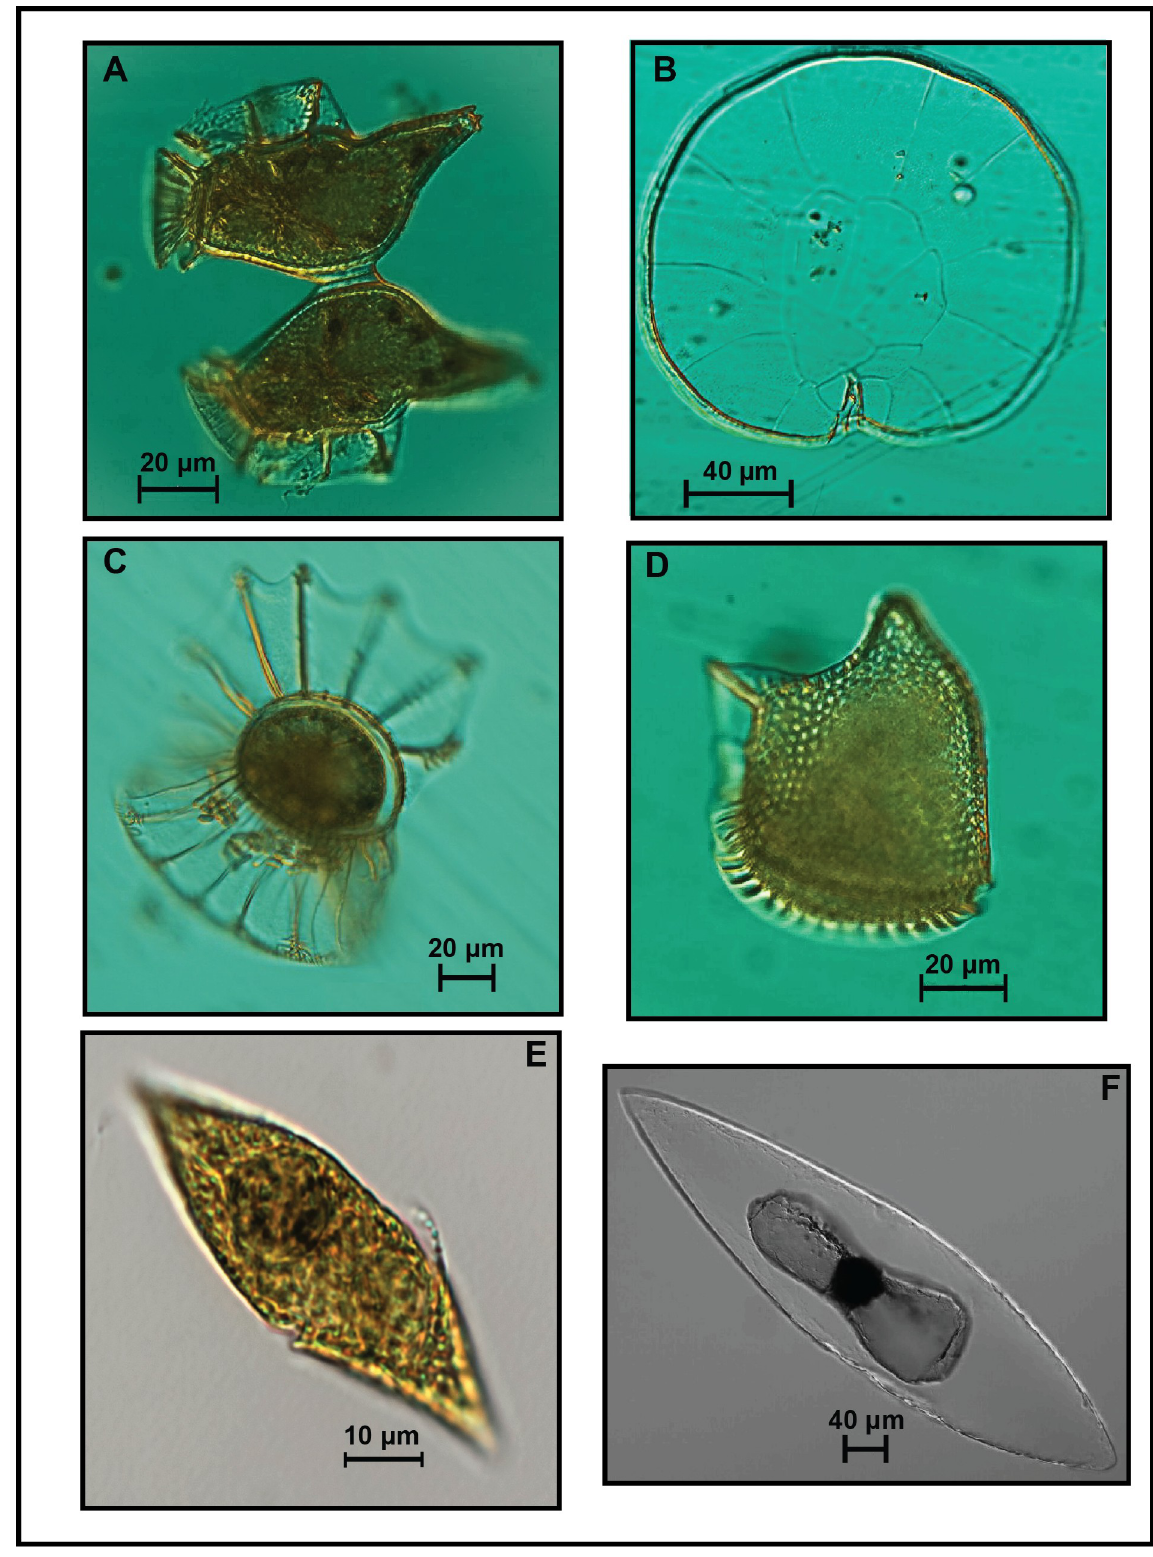
Fig 3. Microscope images of dinoflagellate genera collected in oceanic waters of the SGoM. (A) Dinophysis , (B) Pyrophacus , (C) Ornithocercus , (D) Phalacroma , (E) Gyrodinium , and (F) Pyrocystis . Scale bars are indicated for each picture. https://doi.org/10.1371/journal.pone.0247071.g003 PLOS ONE | https://doi.org/10.1371/journal.pone.0247071 February 17,